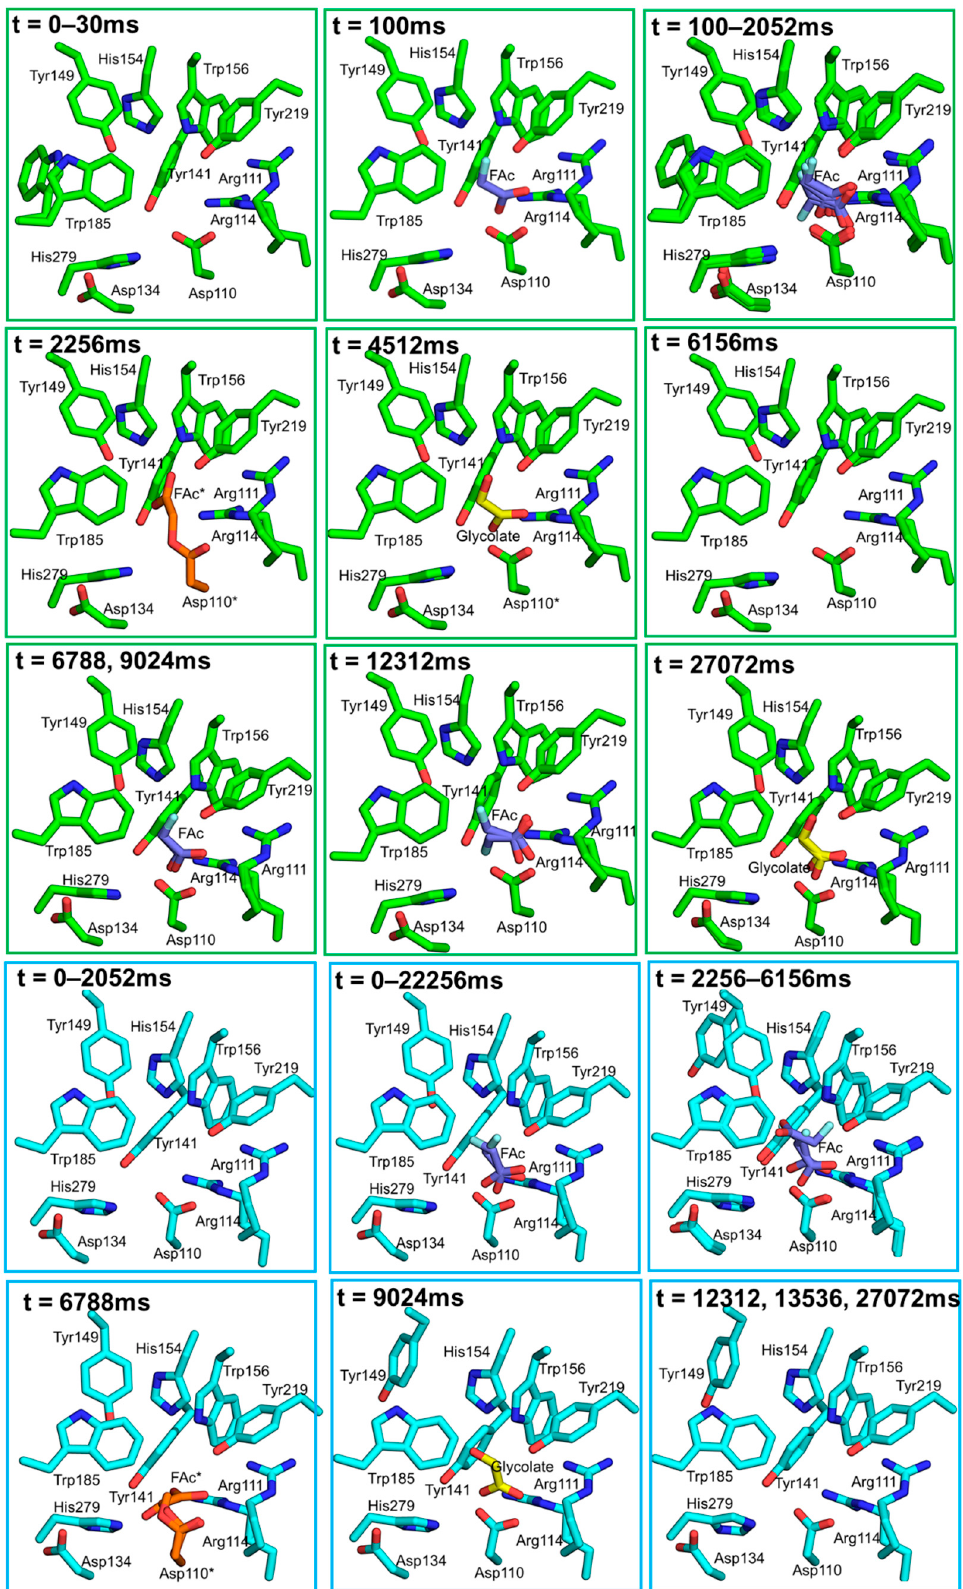
Figure 2. TR-SSX for FAcD with HARE system. All changes occurring at both catalytic sites of FAcD (green boxed for protomer ( A ) and blue boxed for protomer ( B ) captured during the experiment are represented. The key residues at the catalytic site, the substrate (FAc) and the product (glycolate) are highlighted and represented as sticks.